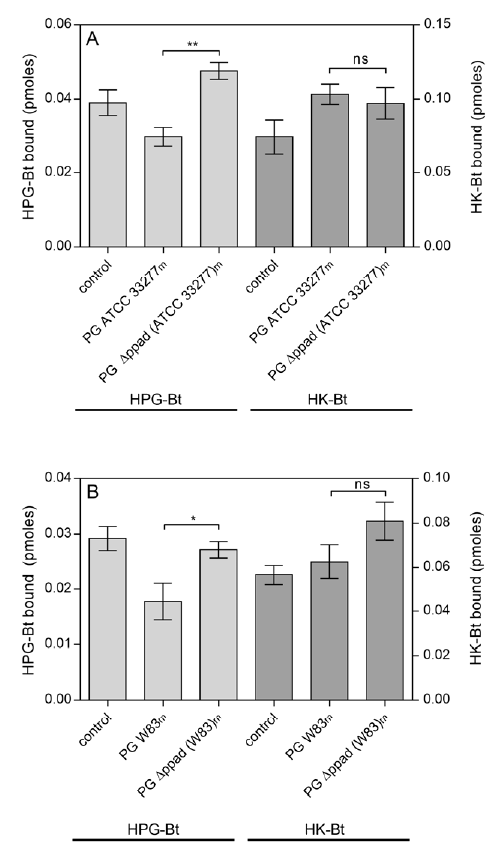
Figure 2. Binding of the human plasma proteins HPG ‐ Bt and HK ‐ Bt to C. albicans hyphae pretreated with enzymes secreted into the growth medium (m) by P. gingivalis (PG) strains: ( A ) ATCC 33277 and Δ ppad (ATCC 33277) and ( B ) W83 and Δ ppad (W83). C. albicans cells were incubated for 6 h in RPMI 1640 medium with the further addition of media collected after P. gingivalis culture. Fungal cells grown in RPMI 1640 medium with BHI or TSBY broth instead of culture supernatants from appropriate P. gingivalis strains served as a control. The bound biotinylated human protein was quantified using the SA ‐ HRP/TMB detection system. Results from representative experiments are shown; bars represent the mean values ± SEM. Statistical analysis was performed by one ‐ way ANOVA with a Tukey’s multiple comparisons test ( p < 0.05) using GraphPad Prism software (GraphPad, LaJolla, CA, USA). Statistical significance levels are indicated: * p < 0.05; ** p < 0.01; ns, non ‐ significant.